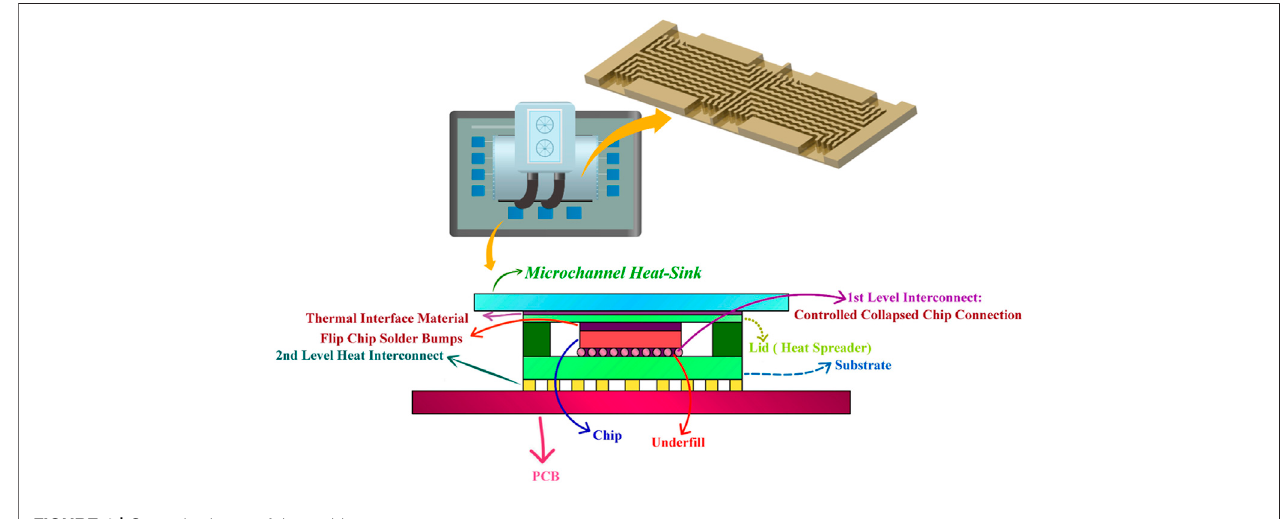
FIGURE 1 | General scheme of the problem.